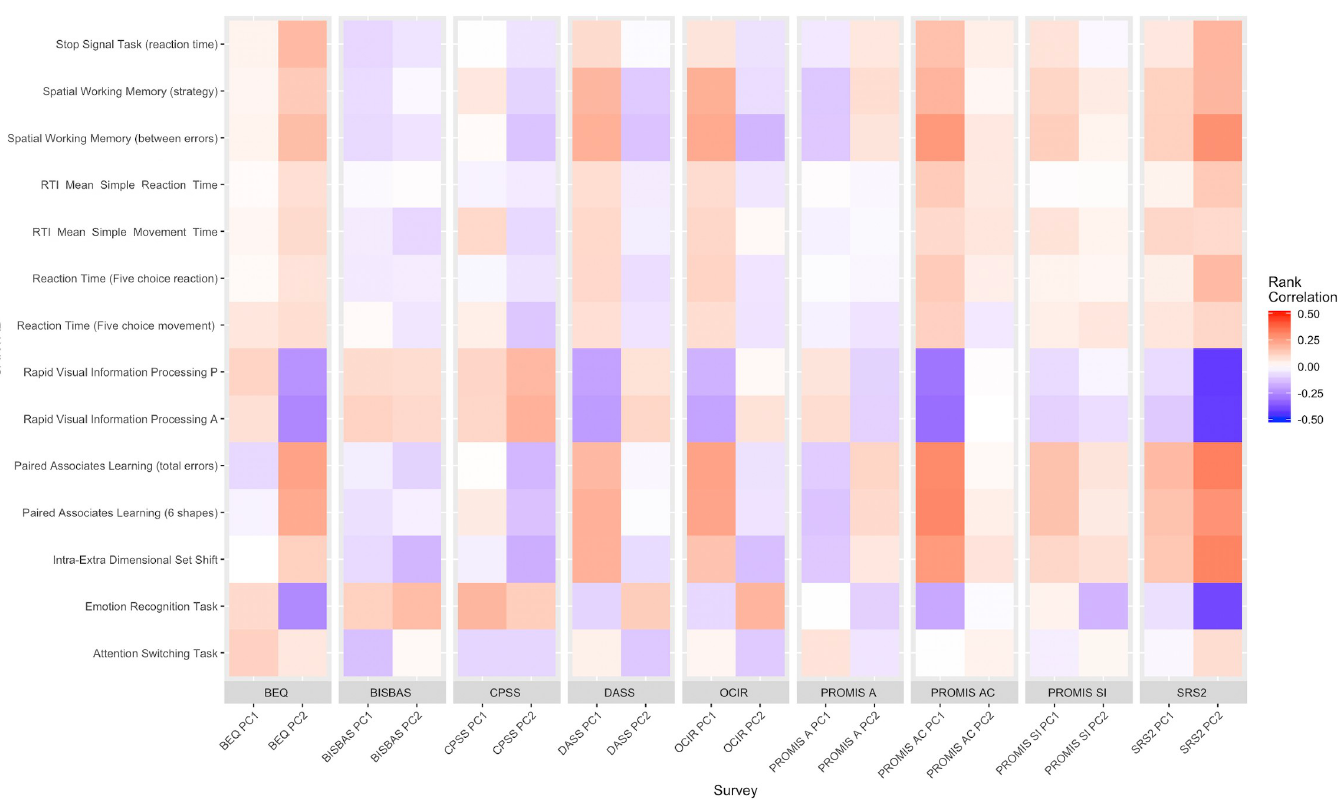
Fig 3. Single survey rank correlation heatmap: We calculate the rank correlation between the first two principle components of the 9 questionnaires, and some selected CANTAB cognitive score metrics. Positive correlations are indicated in red, negative correlations in blue, with strength of correlation indicated by color